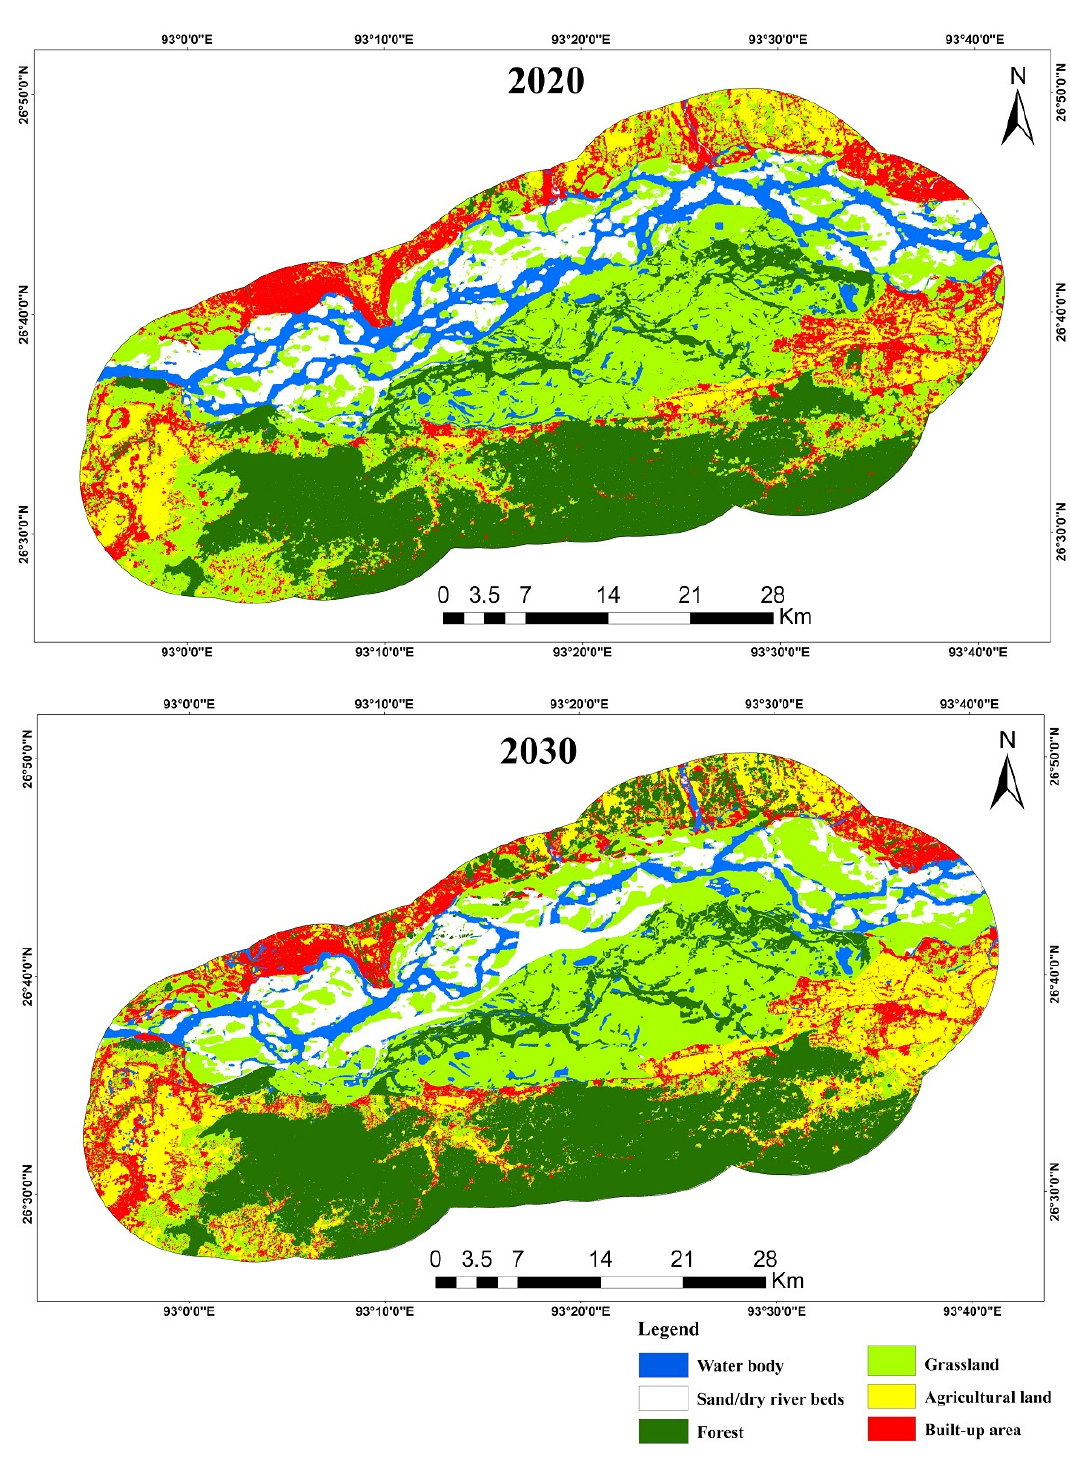
Figure 7. Predicted LULC of Kaziranga Eco-Sensitive Zone for the years 2020 and 2030.